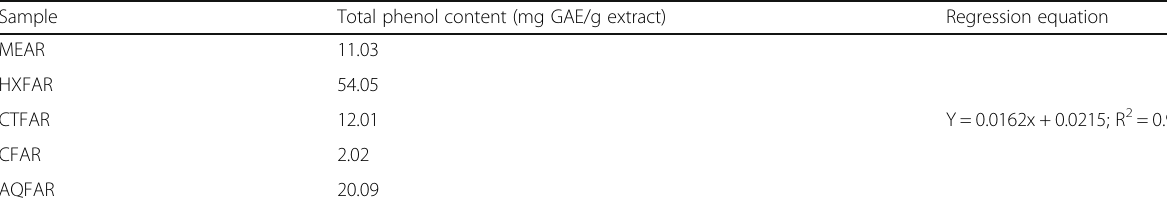
Table 2 Effect of different extractives of stem of Albizia richardiana on Total phenol content Sample